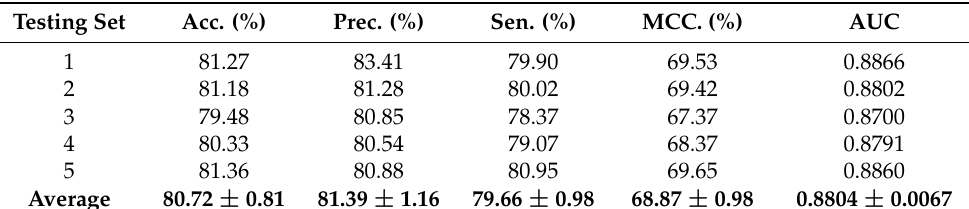
Table 4. Prediction performance of the Yeast dataset based on five-fold cross-validation method.